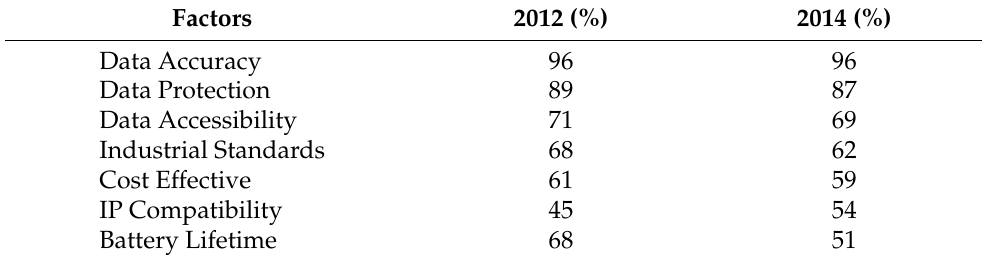
Figure 3. Classification of industrial wireless sensor networks. Table 1. Adopting factors for wireless technology in industrial automation